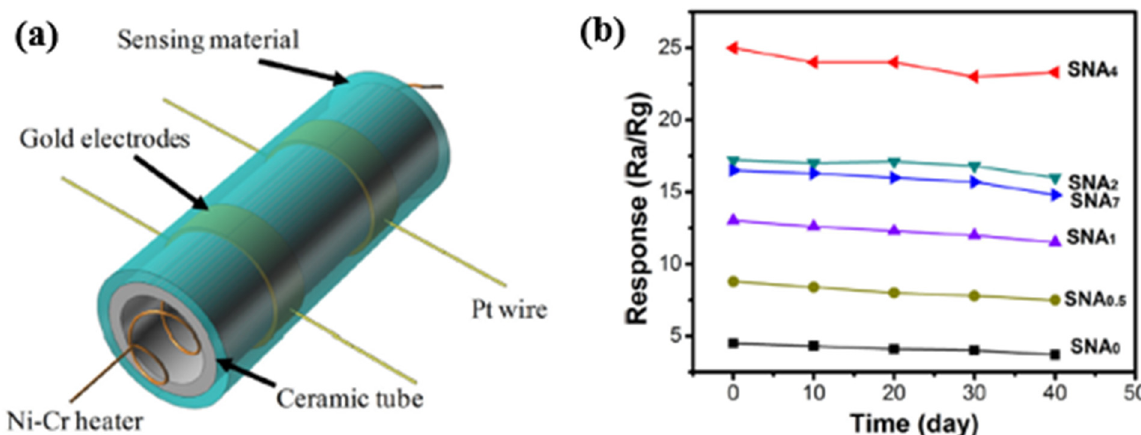
Figure 26. ( a ) Schematic diagram of SnO 2 gas sensing element. ( b ) Long-term stability of the prepared gas sensors to 100 ppm H 2 at their optimum temperatures [115]. Copyright (2017), with permission from Elsevier.